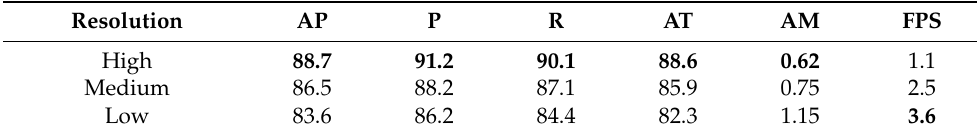
Table 6. Detection results when using images with different resolutions.